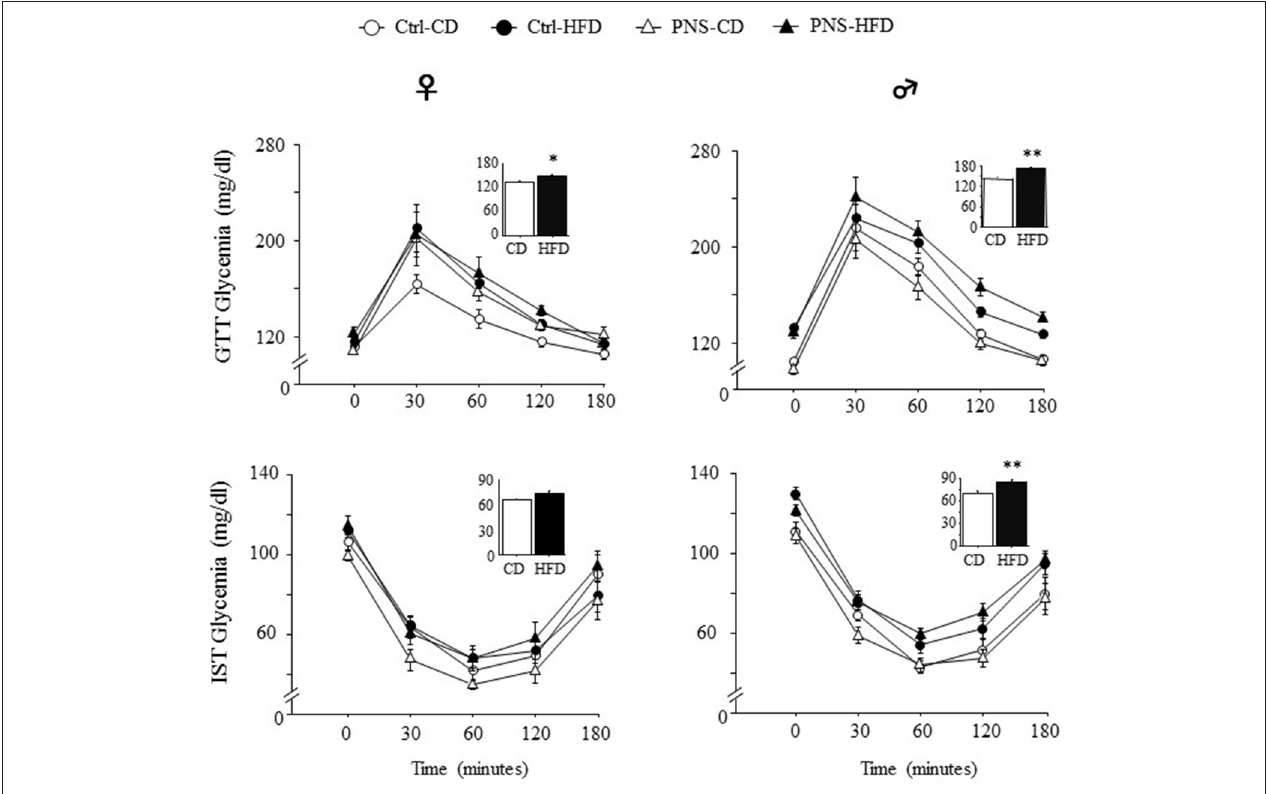
FIGURE 2 | Time course of changes in glycaemia as a result of Glucose tolerance test (GTT) and Insulin sensitivity test (IST) indicate decreased glucose tolerance and insulin sensitivity in subjects fed HFD, with greater effects in males. Data are shown as mean + SEM. * p < 0.05, ** p < 0.01, main effect of Diet.